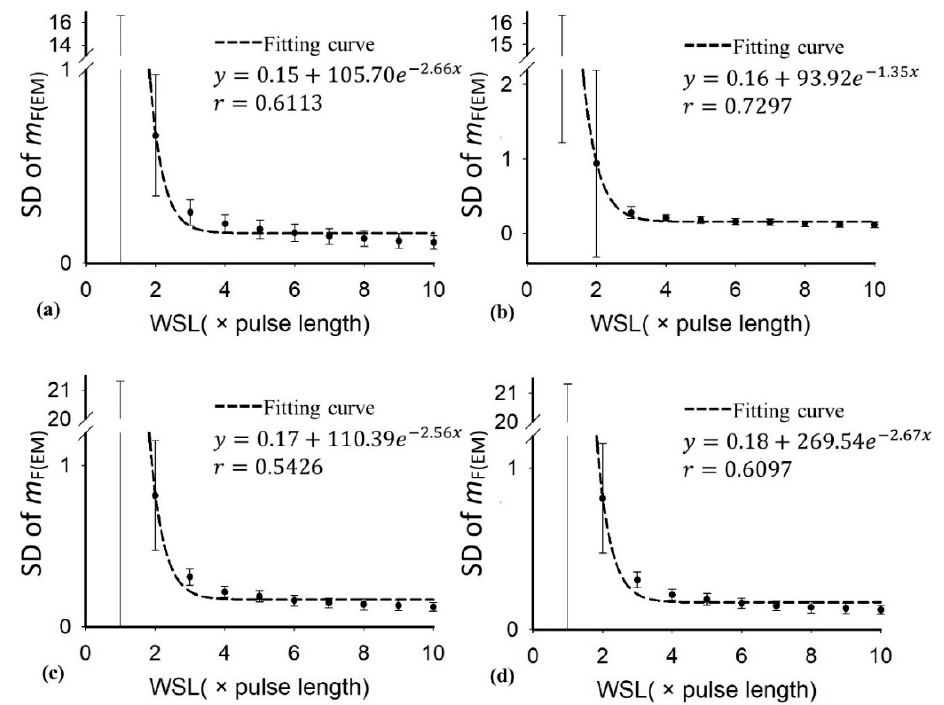
Figure 7. SD of the parameter m F(EM) in the ROI as a function of the WSL obtained with different grades of hepatic steatosis: ( a ) normal; ( b ) mild; ( c ) moderate; ( d ) severe. By increasing the WSL, the SD of the parameter m F(EM) gradually decreased, and the fitting curve plateaued when the WSL was larger than 5 PL.